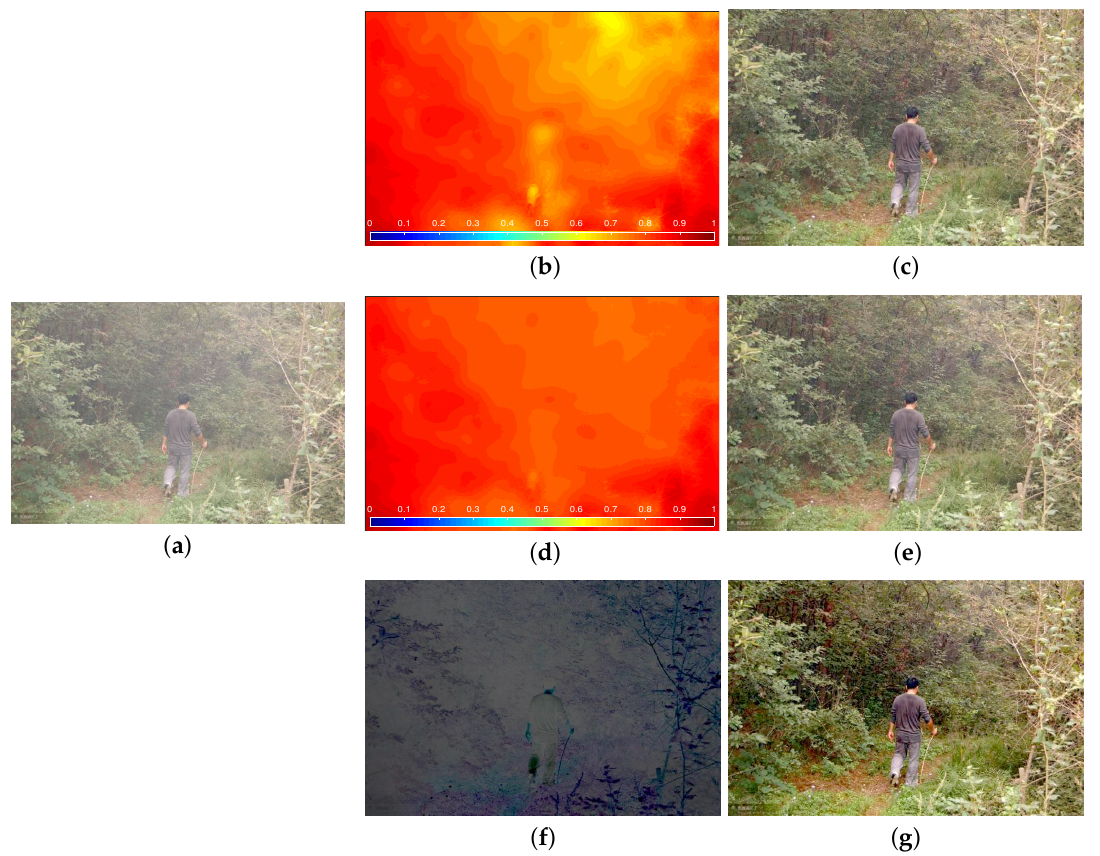
Figure 4. Dehazing example on a image without sky regions. ( a ) Hazy image; ( b ) the transmission of DCP; ( c ) the result of DCP; ( d ) our offset-corrected transmission; ( e ) our result with offset correction; ( f ) our weighted residual map; ( g ) our final